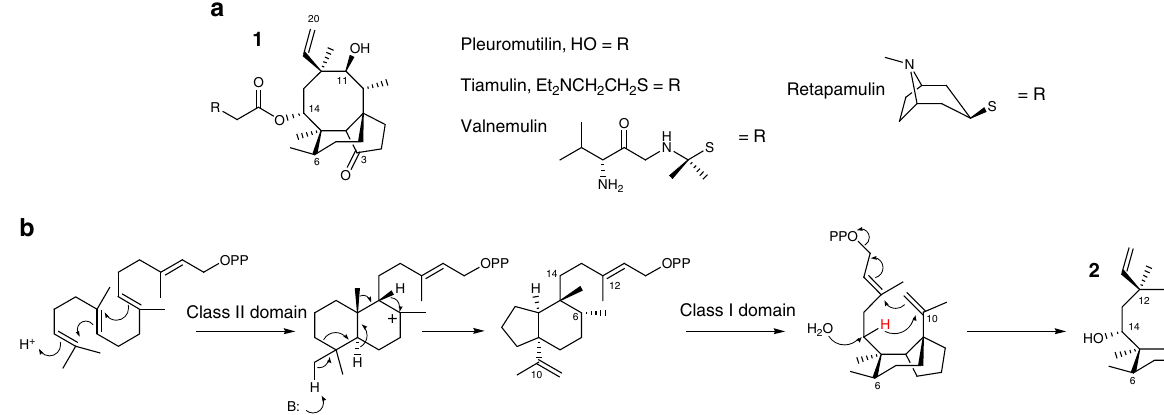
Fig. 1 Pleuromutilin commercial derivatives and proposed cyclisation mechanism. a Structure of pleuromutilin and its commercial derivatives. b Outline of cyclisation to the pleuromutilin tricyclic scaffold, as reported by Arigoni 4, 5 and Birch et al. 6 . The class II terpene synthase domain of Pl-Cyc promotes ring contraction during the protonation-dependent cyclisation of GGPP. The class I terpene synthase domain then catalyses formation of the 8-membered ring through ionisation-dependent dephosphorylation. Trapping with water introduces the fi rst hydroxy group of the molecule at C-14 of the tricyclic